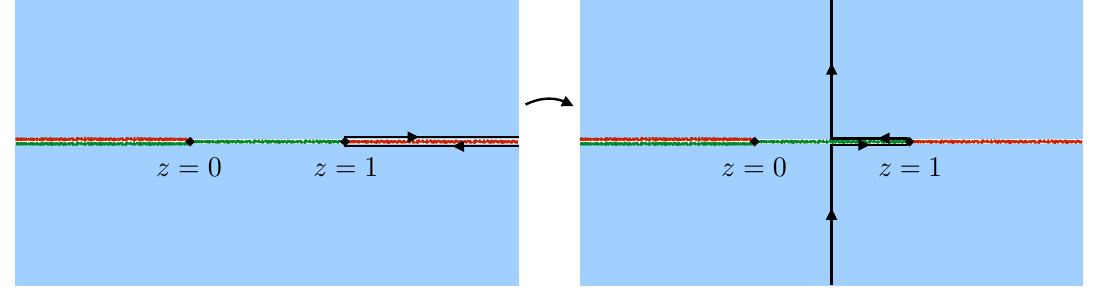
Figure 3 . The contour deformation we can use to go from the representation of a general func- tional (3.4) in terms of h ( z ) to the more convenient representation (3.1) in terms of f ( z ) and g ( z ). The branch cuts of F (cid:1) (cid:30) ( z ) are shown in red and the branch cuts of h ( z ) are shown in green. When- (cid:1) ever we have two integration contours running in opposite directions above and below a branch cut, we are really integrating the discontinuity across the branch